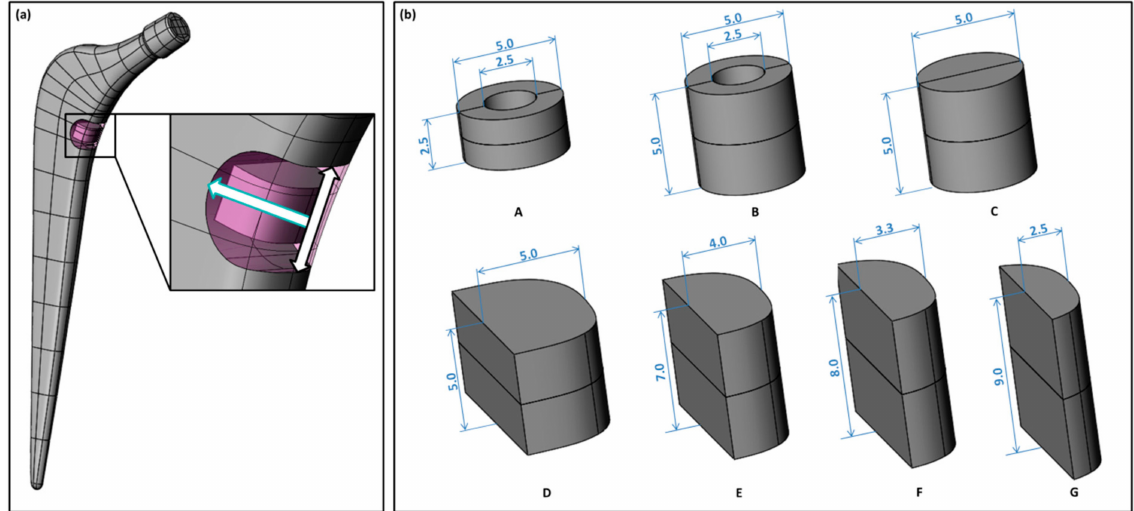
Figure 2. ( a ) Modified hip stem with EHS (UHWM-PE housing in transparent view and exemplary customised piezoelectric element) with detail view. Arrows indicate the cavity depth (blue) and height (black). ( b ) Different piezoelectric element geometries; ( A ) off-the-shelf single element, ( B ) off-the-shelf stacked element, ( C ) full cylinder stacked element, ( D ) initial customised geometry, ( E ) to ( G ) further customised geometries of different heights and depth for first cavity